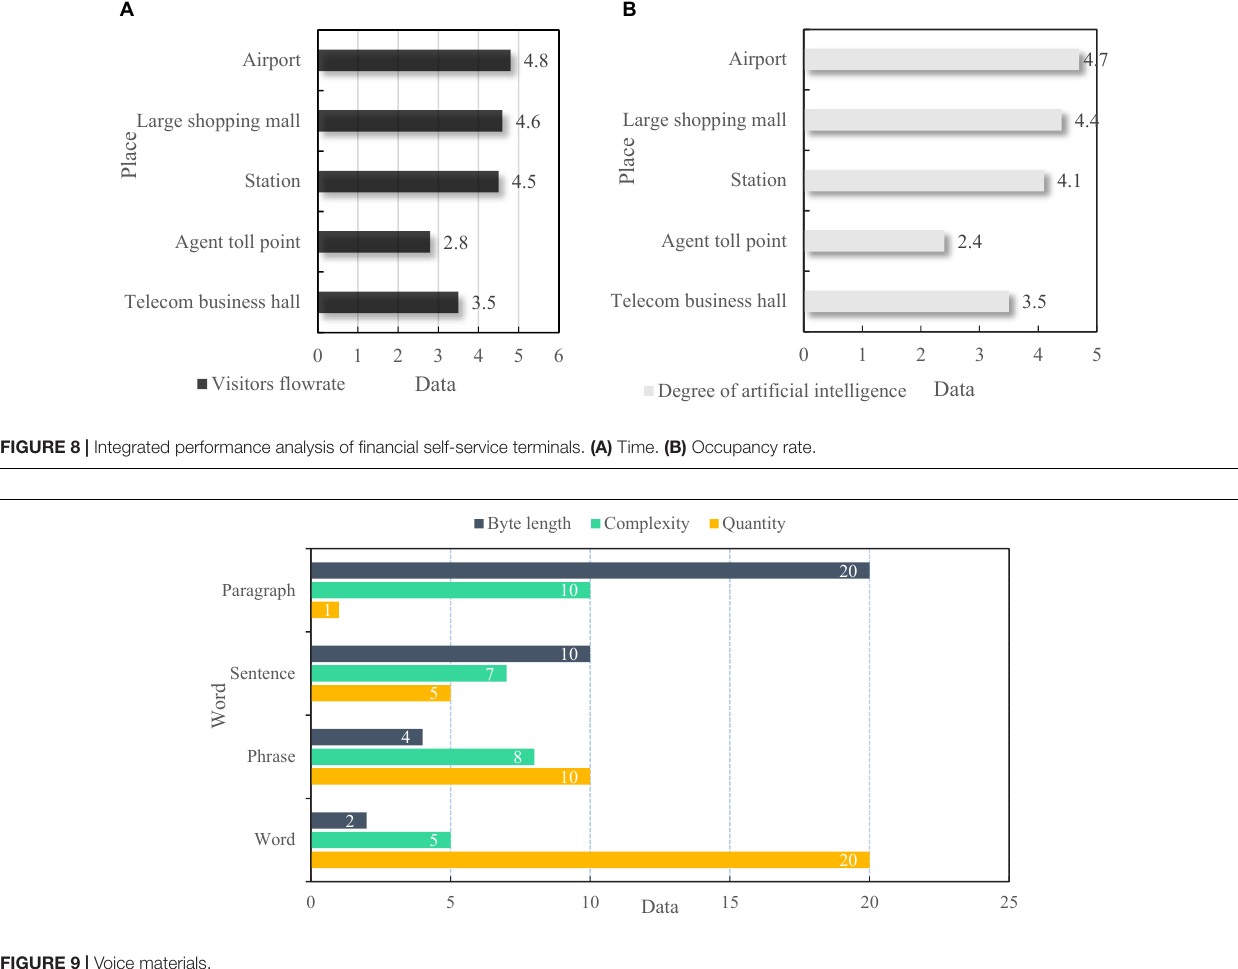
FIGURE 9 | Voice materials.